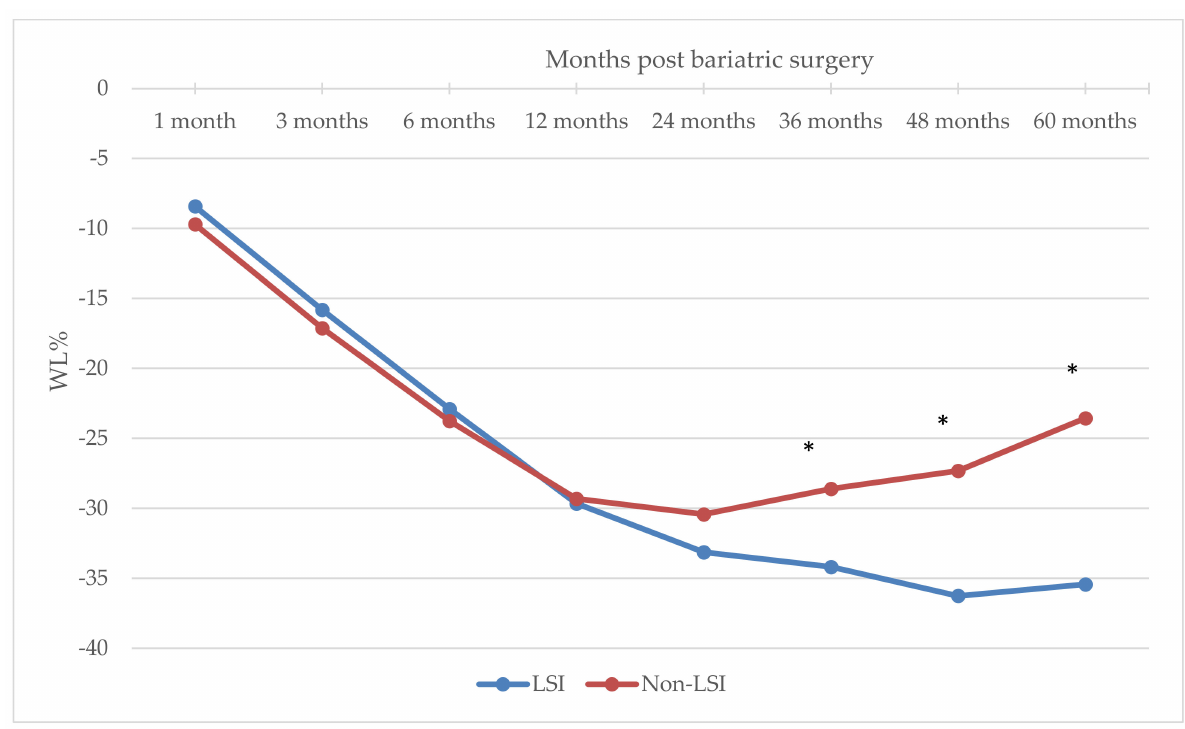
Figure 1. Change in WL% over time in the LSI and Non-LSI groups. * Significant at p <